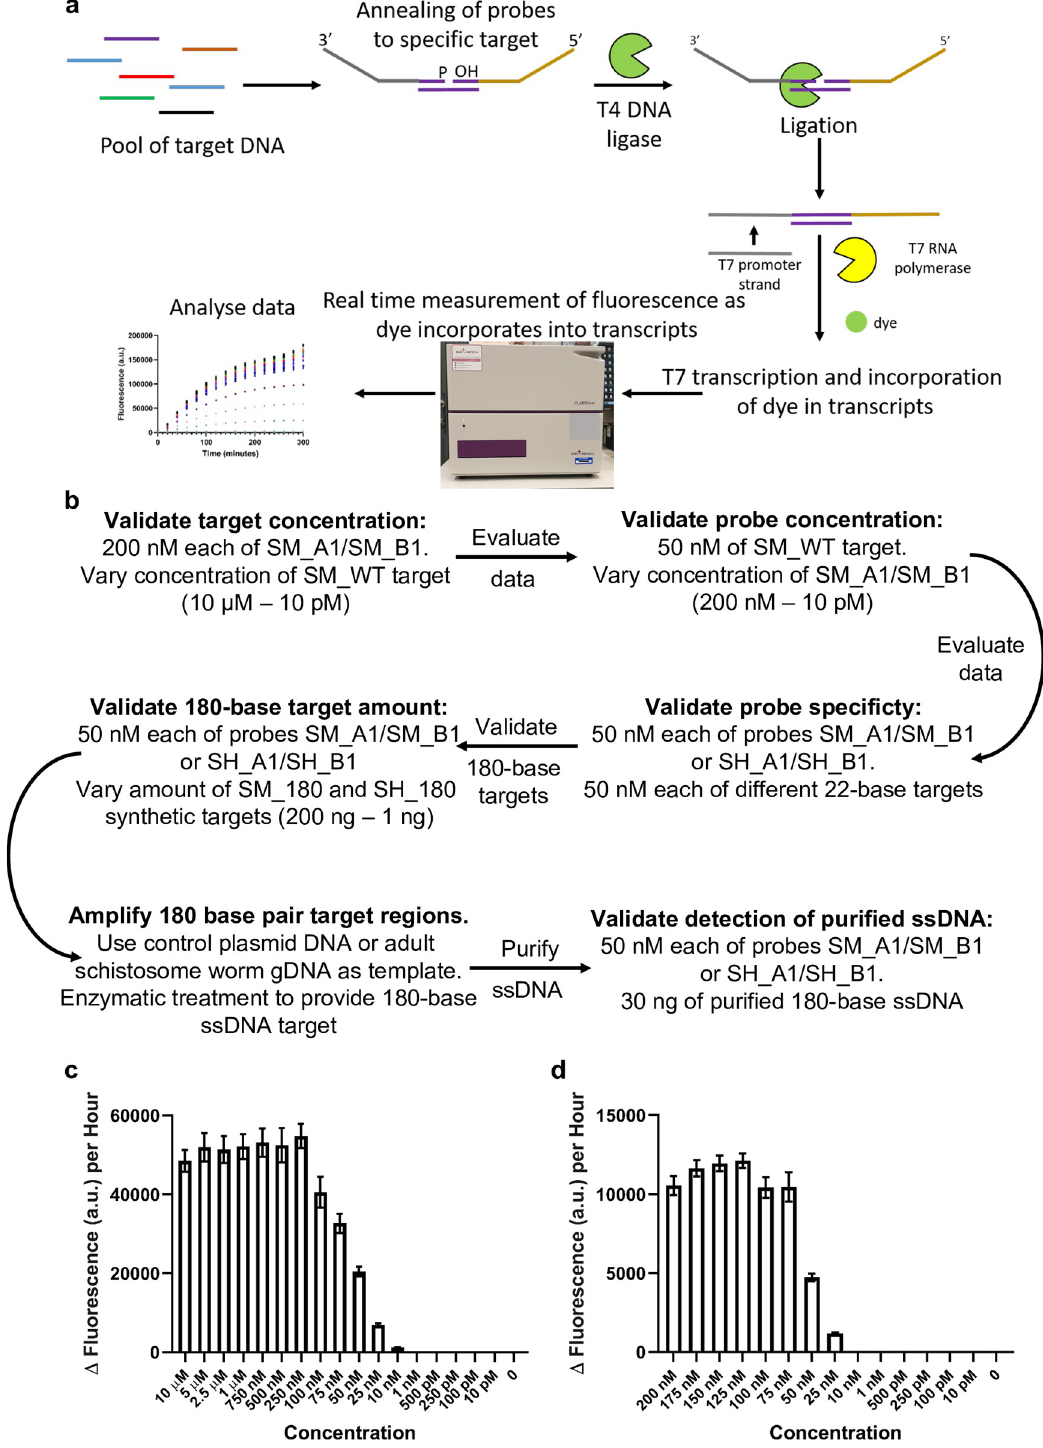
Fig 1. “SNAILS” biosensor workflow and validation. a , Workflow of the ‘SNAILS’ biosensors assay. b , Validation workflow followed for the ‘SNAILS’ assay. c , ‘SNAILS’ biosensor sensitivity. Sensitivity of S . mansoni probe set 1 (SM_A1/SM_B1) against a range of concentrations of the 22-base S . mansoni target (SM_WT, AJW791). Probe concentrations were set to 200 nM of each half probe. n = 12 (4 replicates per reaction, each reaction split into triplicate runs). d , Optimisation of probe concentration. Concentration of probes required to detect 50 nM of S . mansoni 22-base target (SM_WT, AJW791). n = 9 (3 replicates per reaction,